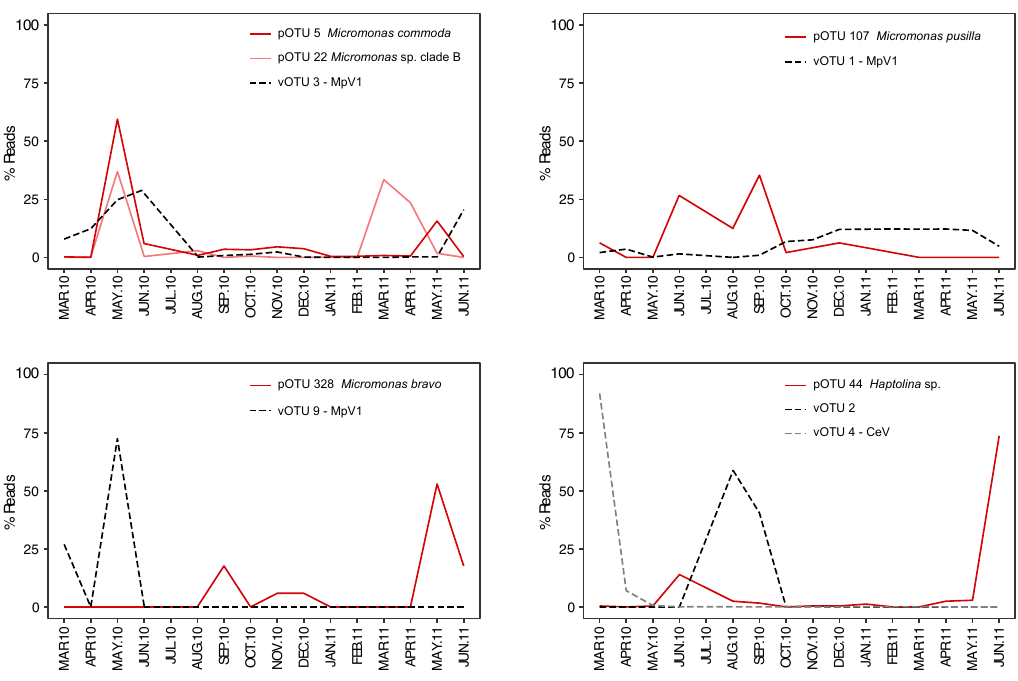
Figure 6. Relative abundances over time of vOTUs matching known viruses (MpV1 and CeV) and their possible host Micromonas commoda and M . sp. clade-B-subarctic, M. pusilla , M. bravo , and Haptolina sp. obtained by Gran-Stadniczeñko et al.